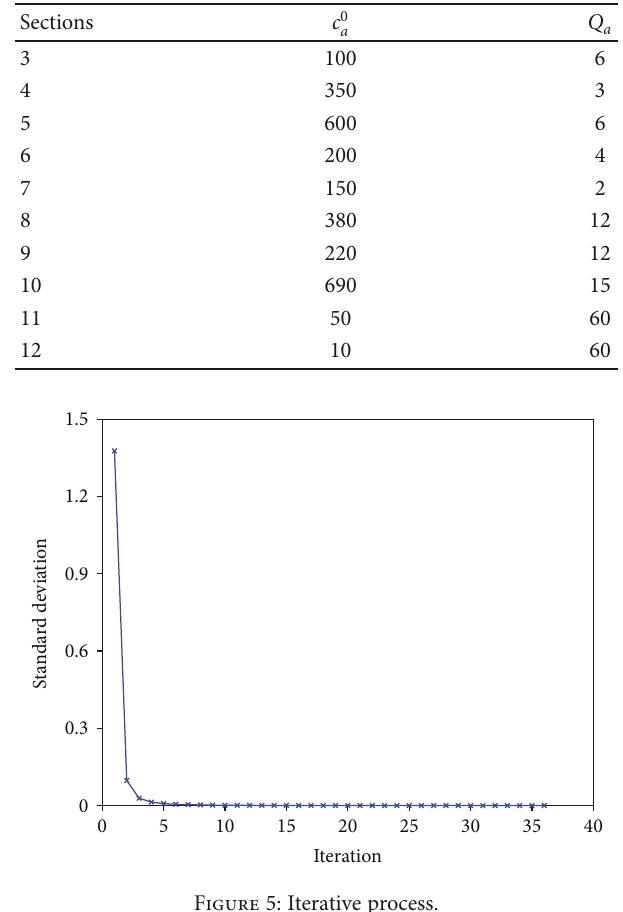
Table 4: Basic parameters of the road section.